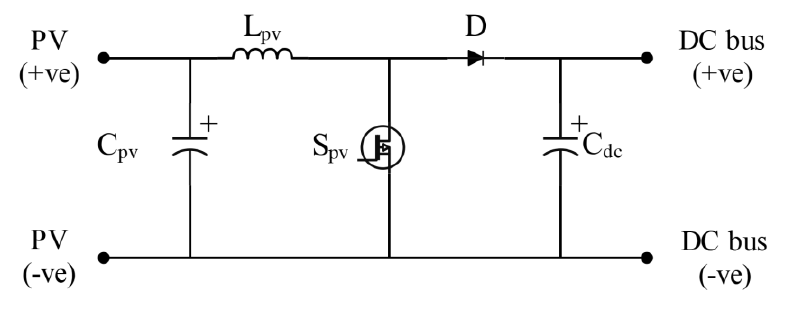
Figure 7 . Model of the PV-side DC – DC boost converter. Figure 7. Model of the PV-side DC–DC boost